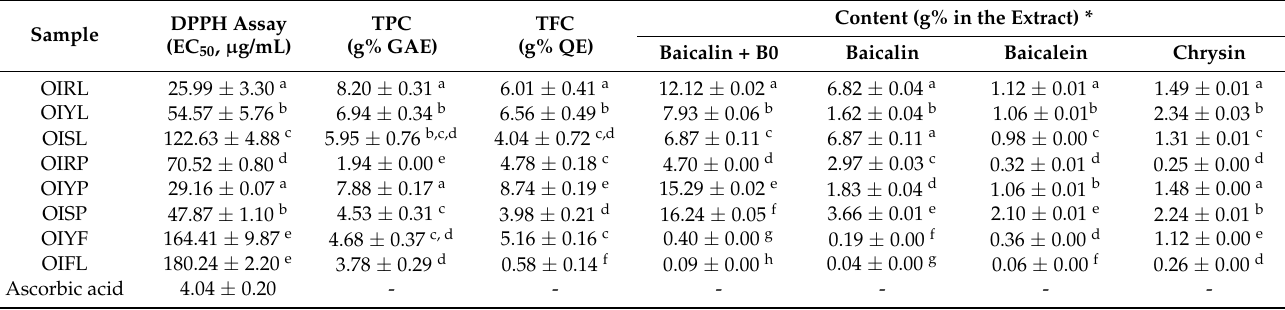
Table 1. Flavonoid Contents in O. indicum Extracts as Determined by high-performance liquid chromatography (HPLC).